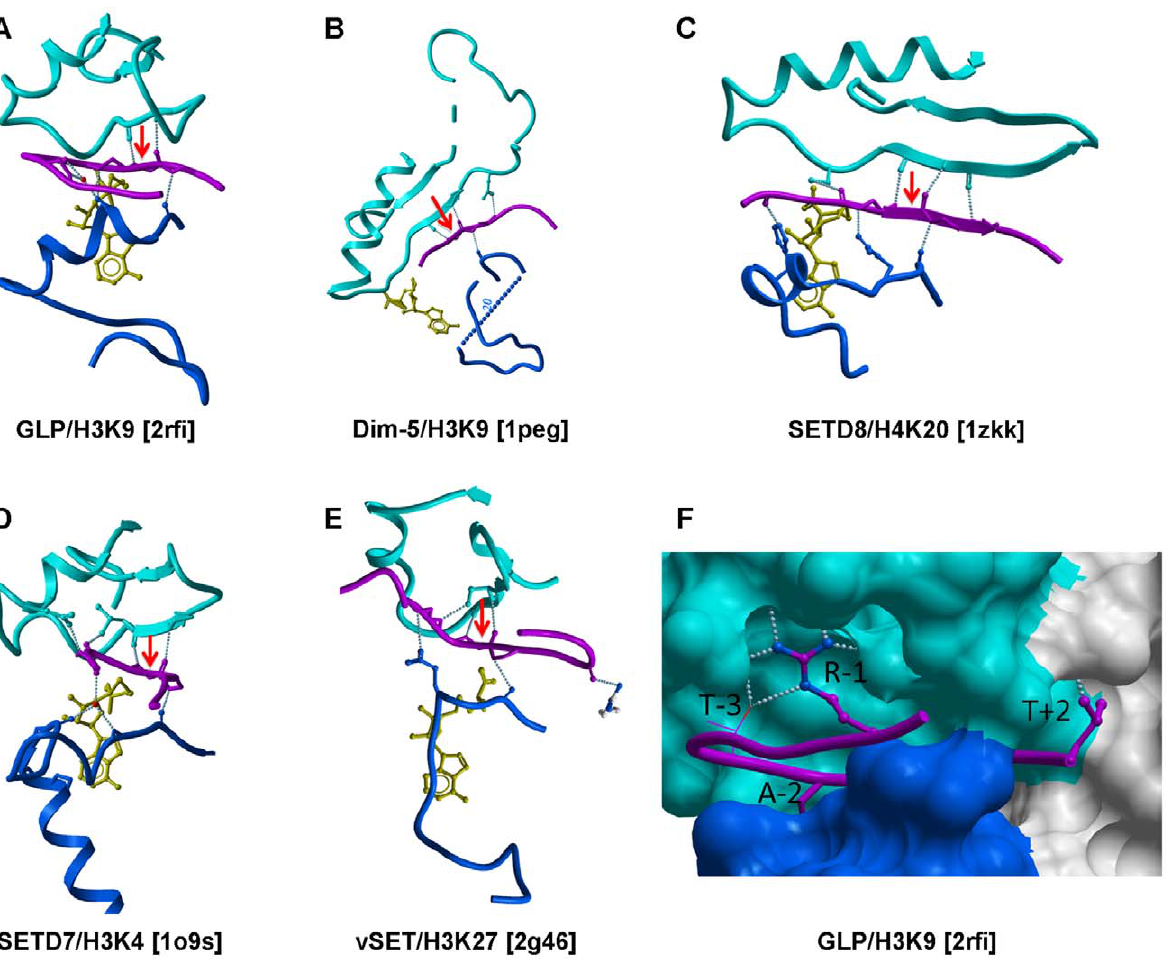
Figure 5. Backbone and side-chain contributions to peptide binding. A–E: Both Post-SET (blue) and I-SET (cyan) backbone atoms are engaged in a network of hydrogen-bonds with the peptide main-chain (magenta). A pair of hydrogen-bonds between backbone atoms of the I-SET and substrate lysine are conserved in all available HKMTs ternary complexes to date (dotted lines flanking red arrow). F: the substrate peptide sits in a groove formed by the I-SET (cyan) and the Post-SET (blue) domains. Peptide side-chains contributing most to the interaction are shown (magenta sticks). The guanidinium group of H3R8 (R-1) makes extensive contacts with the I-SET domain.